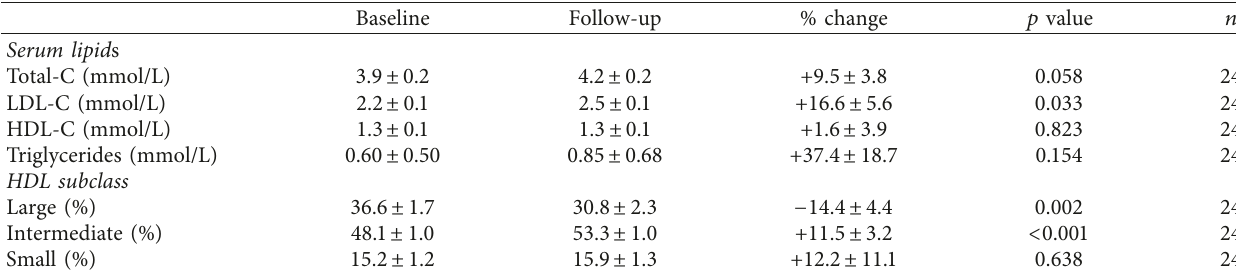
Table 2: Changes in serum lipids and HDL subclass